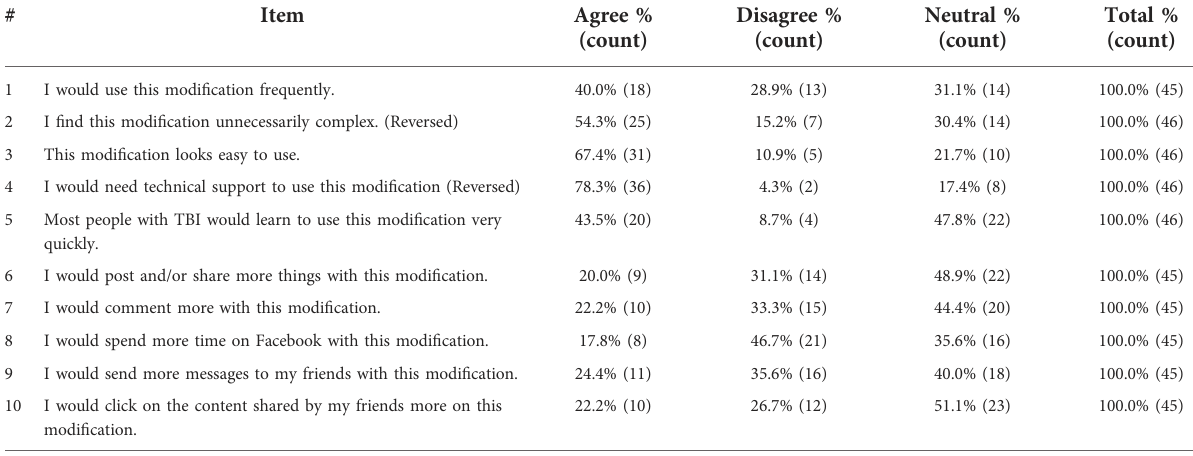
TABLE 6 Summary of participants ’ responses for post-writing ai d. Item